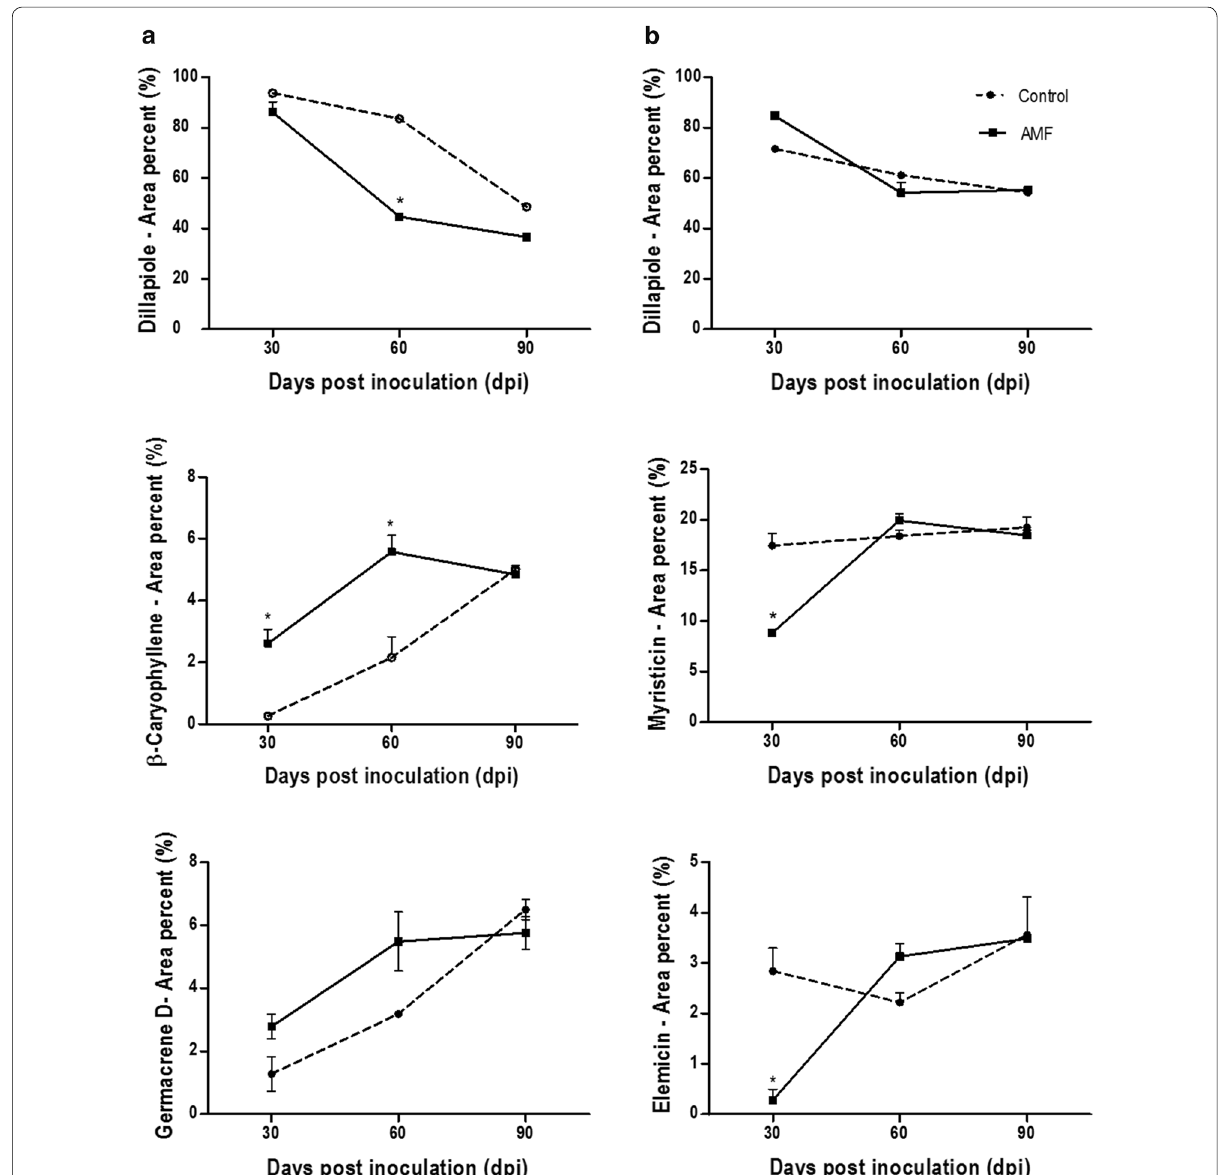
Fig. 2 Major compounds produced by P. aduncum during inoculation with arbuscular mycorrhizal fungi (AMFs). a Leaves; b Roots. *Statistical difference according to Bonferroni test ( p <